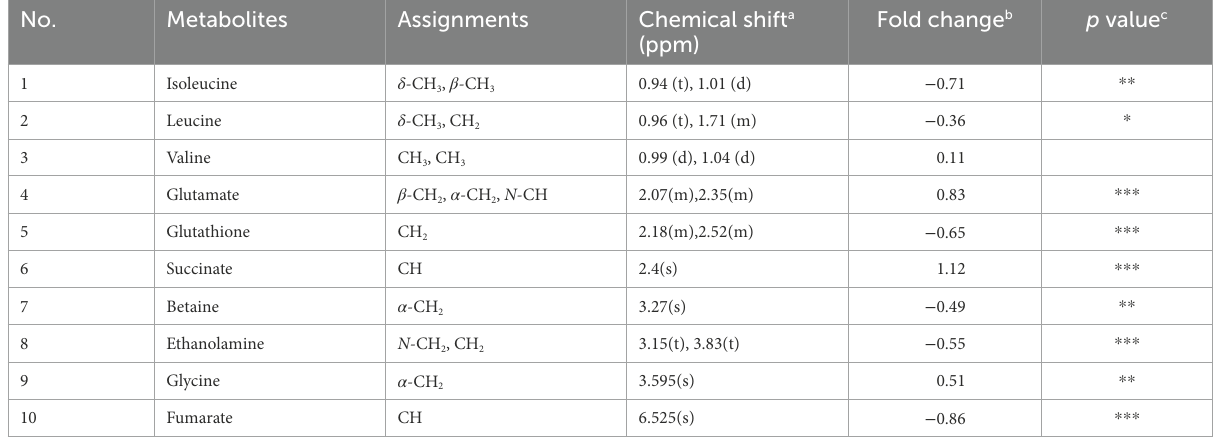
TABLE 3 The assigned metabolites involved in protein synthesis, antioxidation, membrane composition, and energy metabolism.